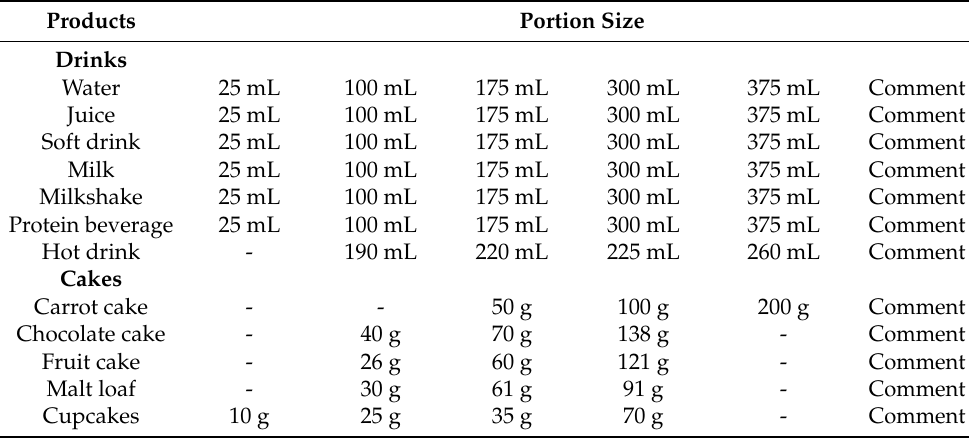
Figure 2. Drink and cake examples from the portion size questionnaire. Consumers circled what they considered to be an ideal portion size from a series of images and if the ideal portion size was not present they could add a comment. Table 1. Overview of portion size questionnaire by product type and portion size.